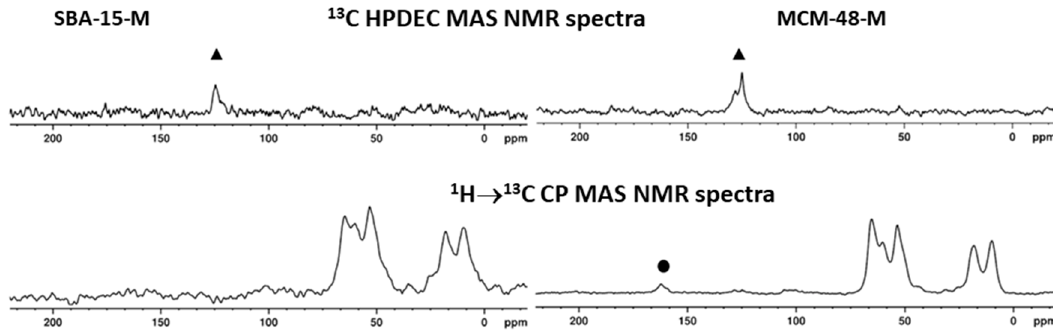
Figure 7. 13 C high power 1 H decoupling ( top ) and 1 H − 13 C CP spectra ( bottom ) of 13 CO 2 adsorbed on SBA-15-M ( left ) and MCM-48-M ( right ). Mainly a small amount of physisorbed CO 2 was detected in both materials.